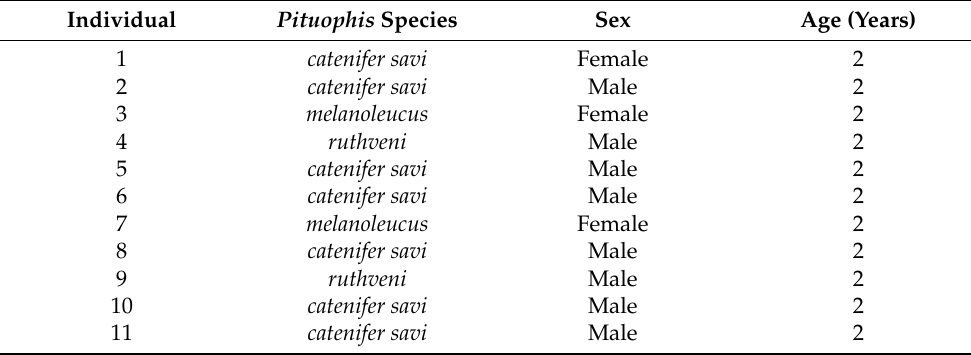
Table 1. Description of Pituophis species used for sample collection during study.